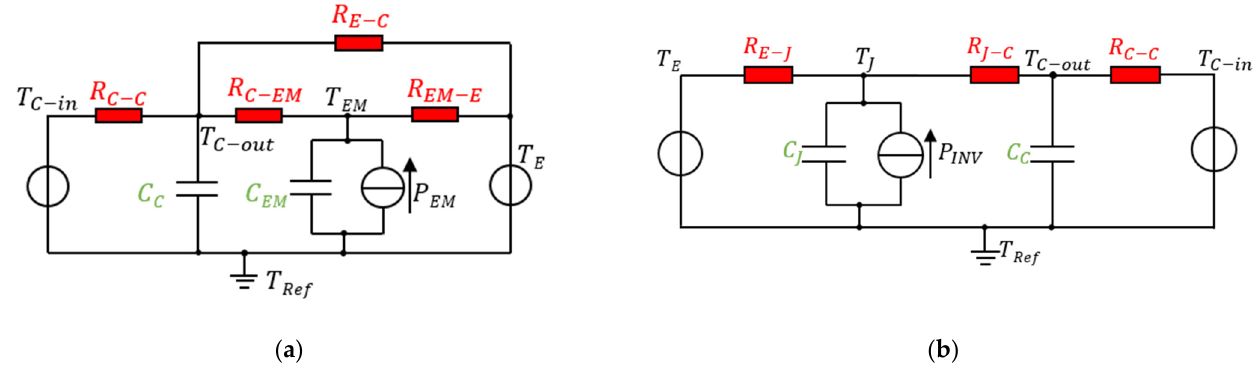
Figure 4. Lumped parameter thermal networks for: ( a ) electric motor; ( b ) inverter.